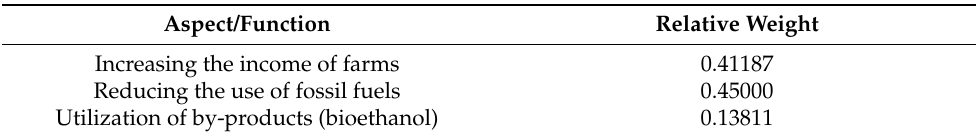
Table 13. Results of the AHP on weighting the relative importance of the economic dimensions of bioenergy